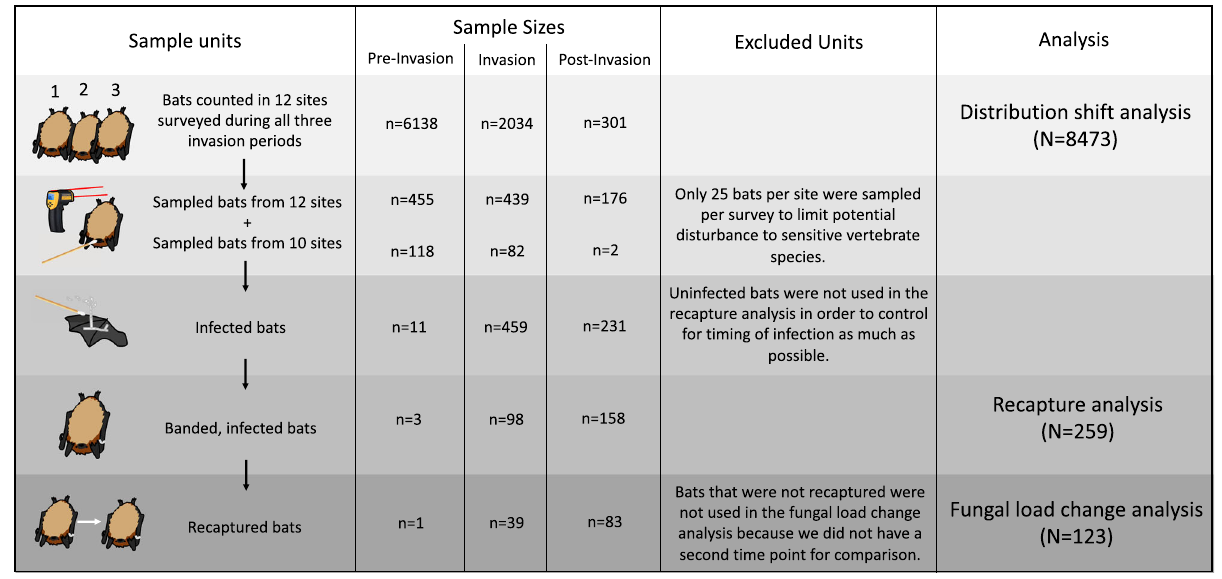
Fig. 2 Survey design and sample sizes for analyses. We surveyed 12 hibernacula before invasion, during invasion (1 – 2 years since detection), and after invasion (>2 years since detection), and we surveyed 10 other hibernacula during at least one of the invasion periods. Bats counted in the 12 long-term sites were included in our analysis of how bat temperature distributions in November shifted from pre-invasion to post-invasion. After counting bats, we sampled up to 25 bats per site per survey, strati fi ed by section, to quantify individual fungal loads and early hibernation roosting temperatures. If these sampled bats could be reached to safely remove them brie fl y from their roosts, we also banded them. All banded bats that were infected during early hibernation were included in our recapture analysis, and all recaptured bats that were infected during early hibernation were included in our fungal load change analysis. Note that only a few bats were infected and banded during Year 0, the year that the fungus was fi rst detected at a given site. We included Year 0 as pre-invasion because bats do not suffer severe disease impacts or mortality in Year 0 (Hoyt et al.) 38 . All sample sizes represent the number of bats sampled during early hibernation.